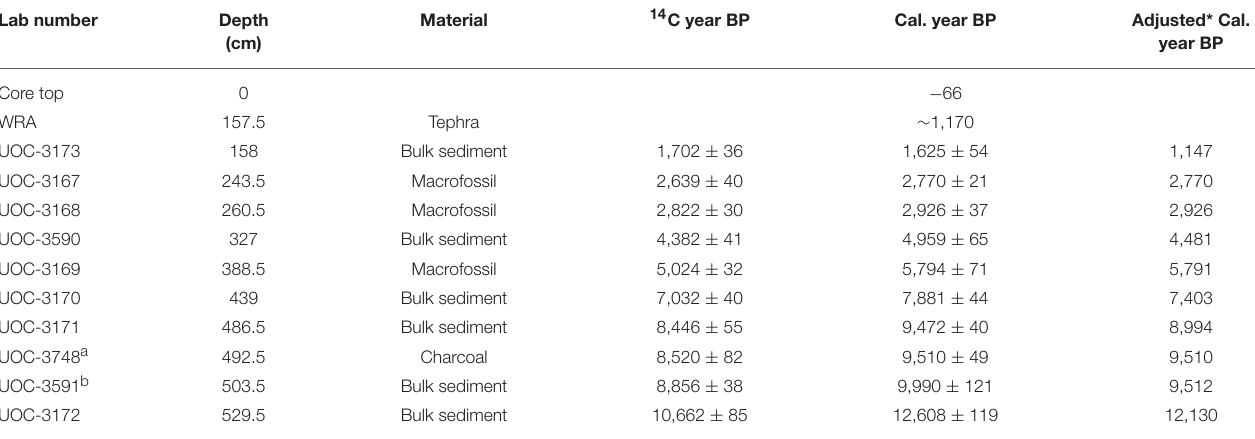
TABLE 1 | Radiocarbon results on bulk sediment and macrofossil samples analyzed at the A.E. Lalonde AMS Laboratory in Ottawa, Canada. Lab